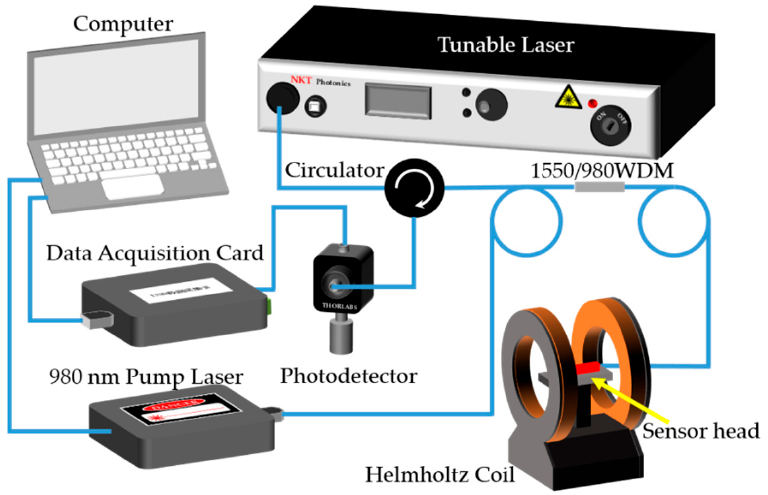
Figure 4. Experimental system setup for AC magnetic field measurement.